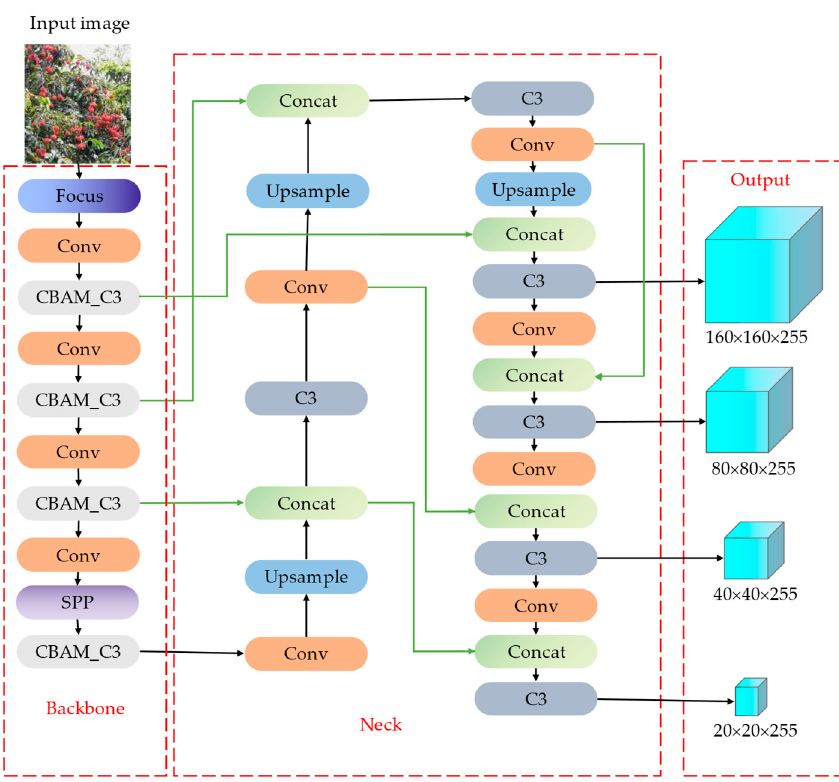
Figure 4. YOLOv5-litchi network structure.